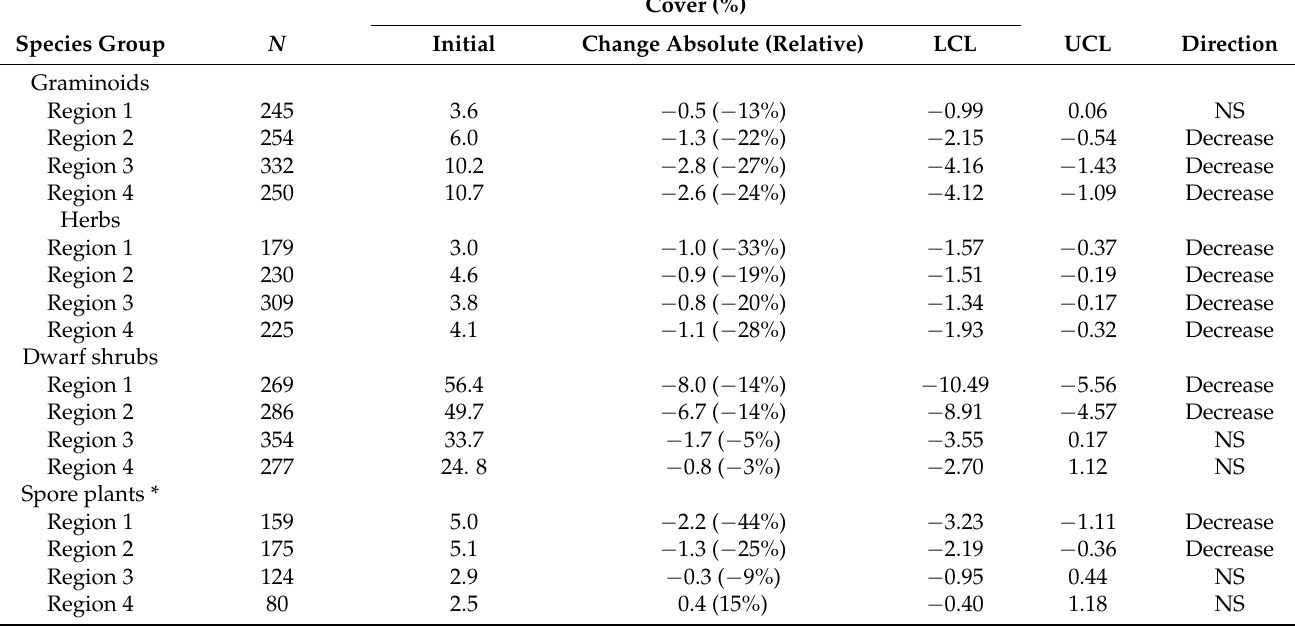
Table 6. Change in cover of six species groups in four regions (see Figure 1). Initial cover denotes the average cover for the first inventory year, while the absolute change and the relative change refer to the average change occurring after 10 years. N refers to the number of plots included in the analysis. The 95% confidence interval for the absolute change is defined by its two limits: the Lower Confidence Limit (LCL) and the Upper Confidence Limit (UCL). NS denotes nonsignificant ( p > 0.05)